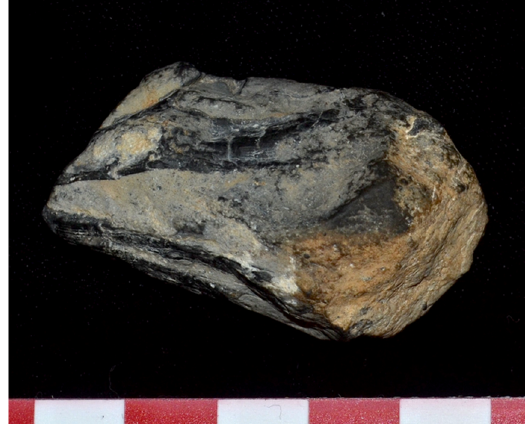
Figure 14. Upper beak rostrum of giant cephalopod. Sagittal view, showing outer edge of beak rostrum. Shaly Limestone Member of the Luning Formation, Nevada, Union Canyon fossil locality east of Berlin-Ichthyosaur State Park, Nevada, Field sample 2 of 16 May 2013, collected by Jessica McMenamin. Scale bar in cm.